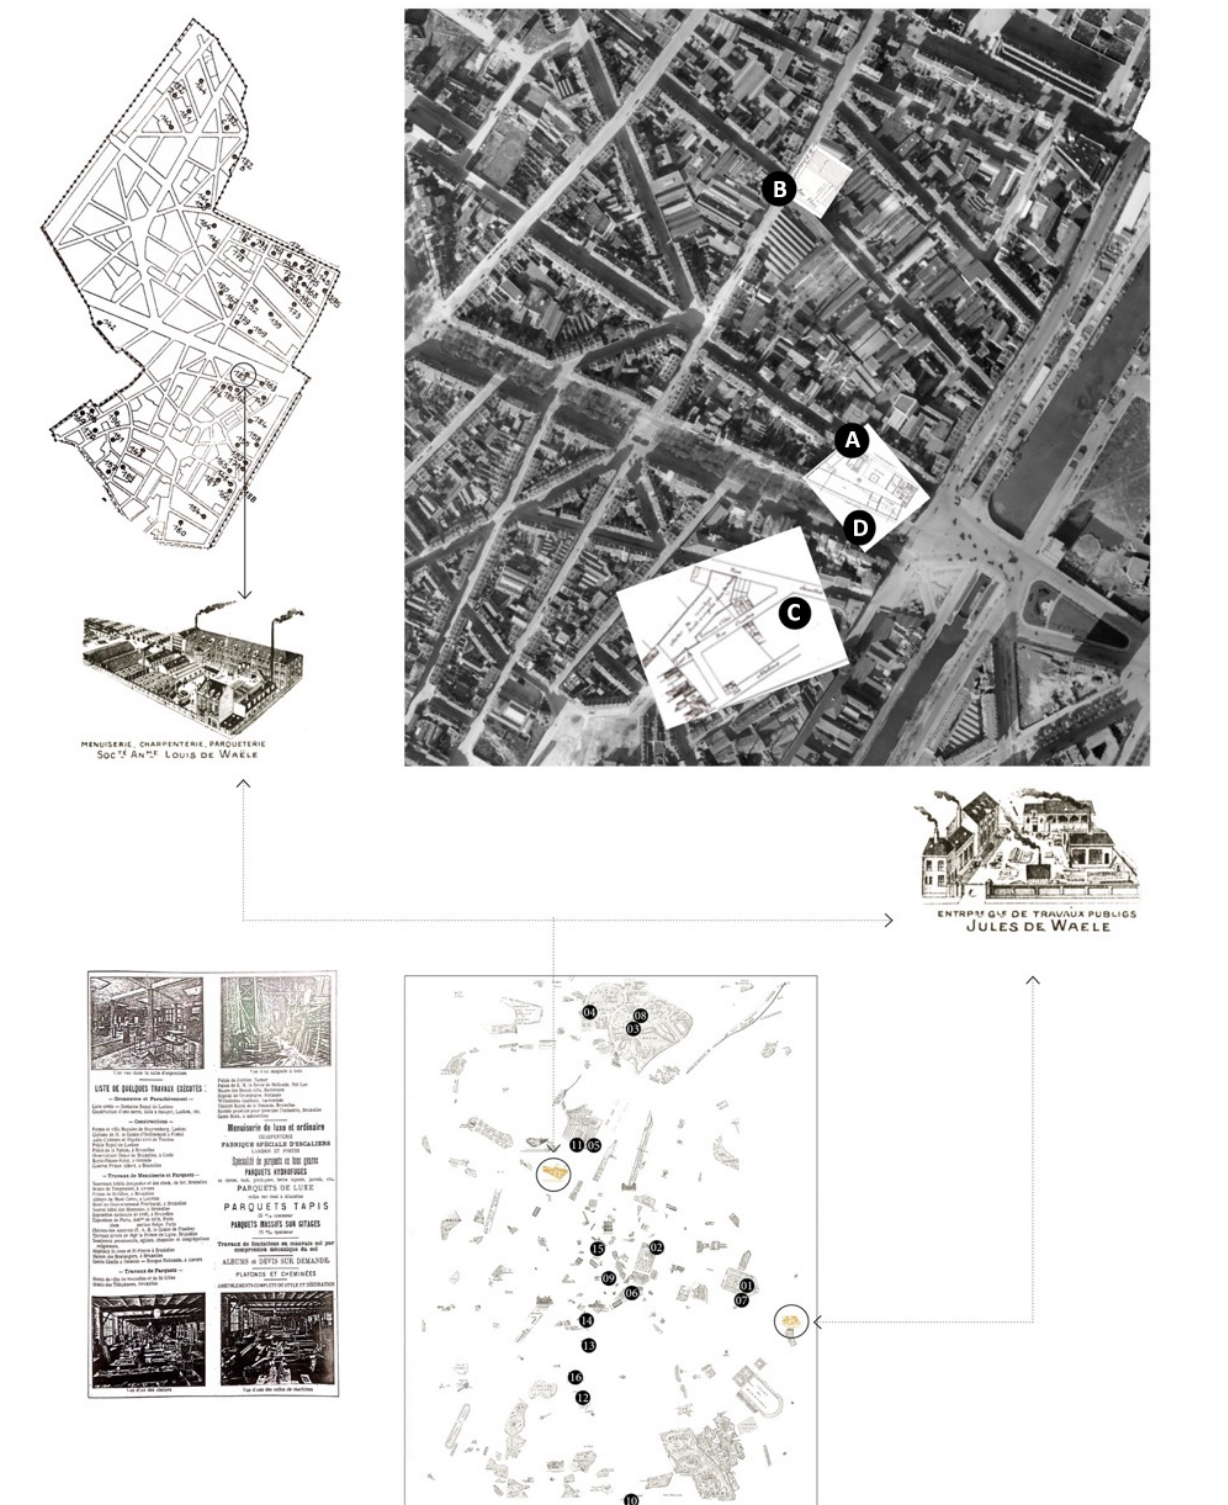
Figure 9. Lisuel layer of the palimpsest. Juxtaposition of archival documents (juxtaposition made by the author). From left to right: location of industrial buildings in Molenbeek (Culot & the AAM, 1980–1982, Vol. 2); aerial photograph mis- sion Brussels 1930–1935 (BUP-CIRB); building permits (Culot & the AMM, 1980–1982, Vol. 2); advertisement for